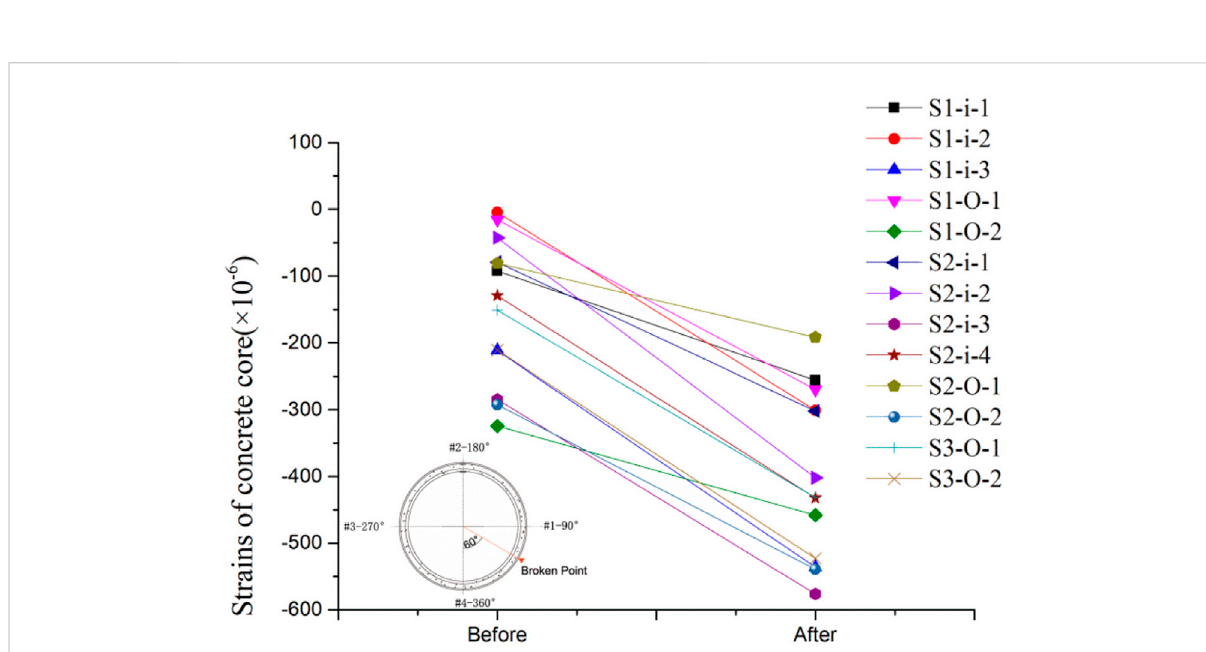
FIGURE 17 Strain comparison of the concrete core before and after the tensioning